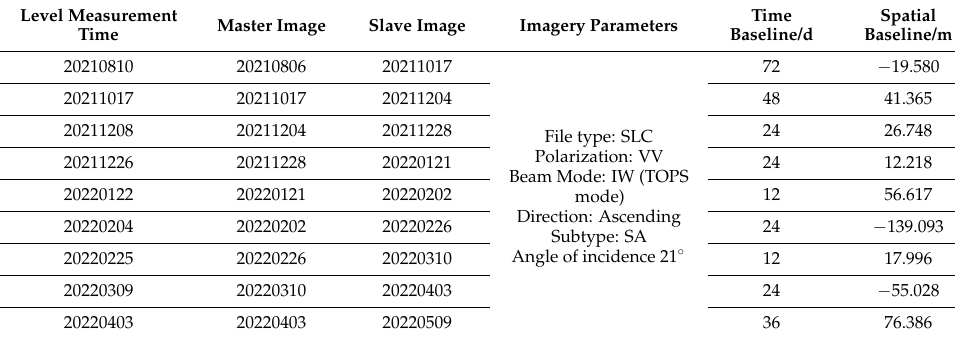
Table 2. Level measurement time and main parameters of SAR imagery.